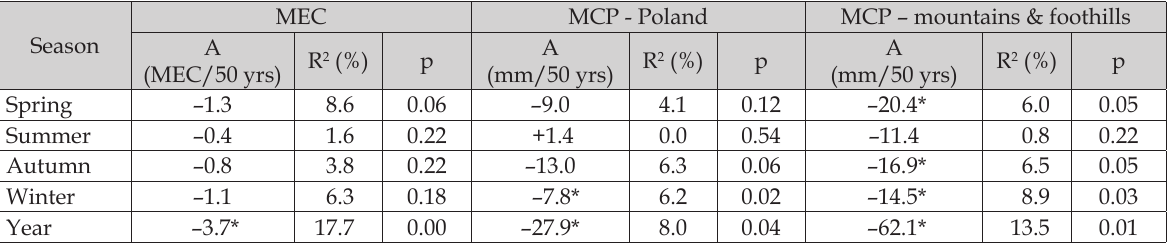
Table 4. Trends in the number of Mediterranean cyclones (MEC) and in the mean MCP in Poland and in the mountains and foothills. Period 1958–2008. A – slope of linear trend, R 2 – coefficient of determination, p – level of significance associated with Mann-Kendall statistics Season